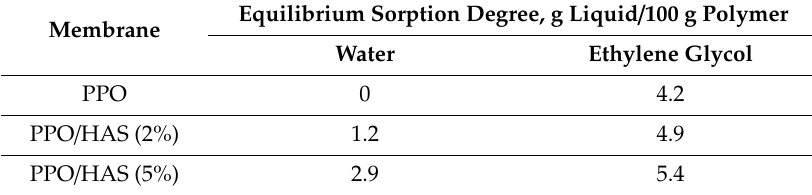
Table 3. Equilibrium sorption degree of liquids by membranes.